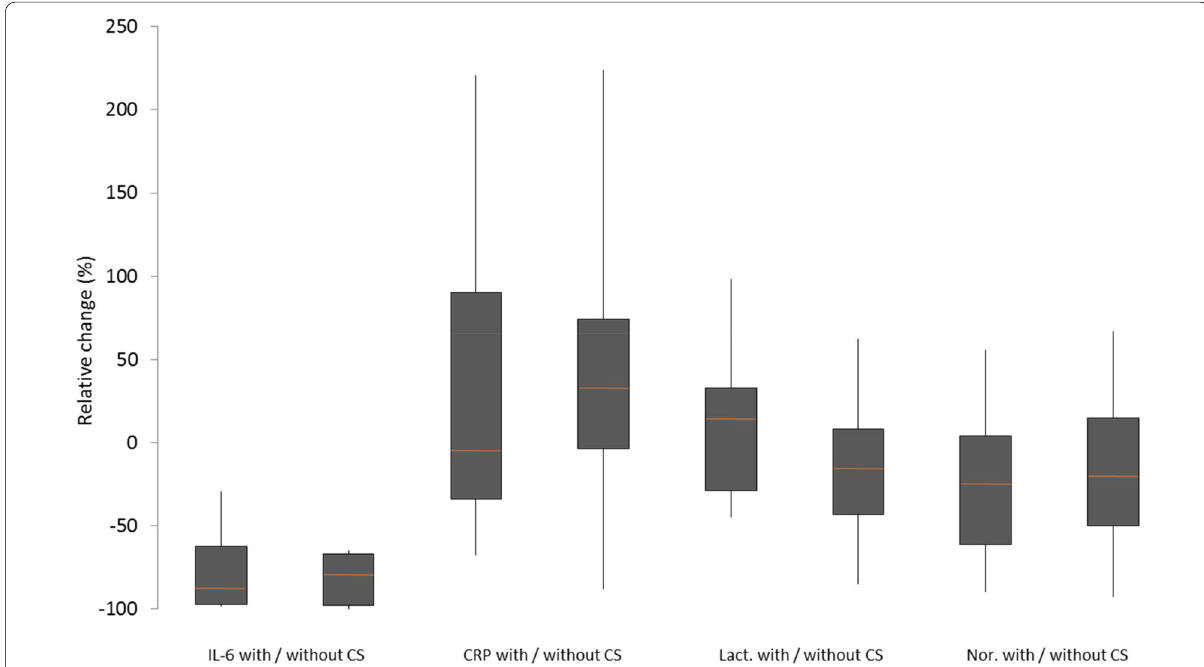
Fig. 1 Relative change of IL-6, CRP, lactate and norepinephrine in patients with and without Cytosorb ® therapy in the matched population. IL-6 interleukin-6, CRP C-reactive protein, Lact lactate, Nor norepinephrine demand, CS Cytosorb